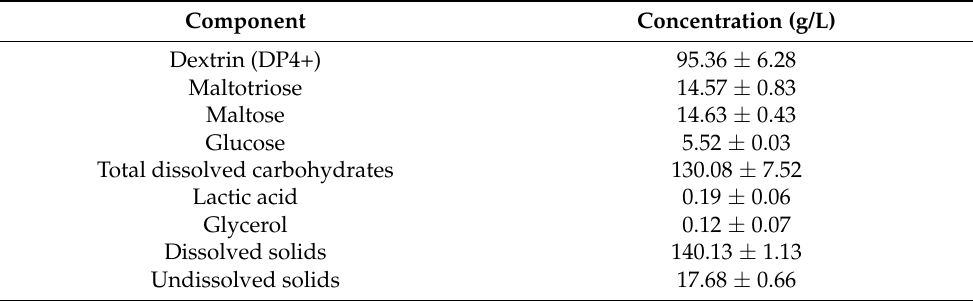
Table 1. Physicochemical features of bread hydrolysate used in this